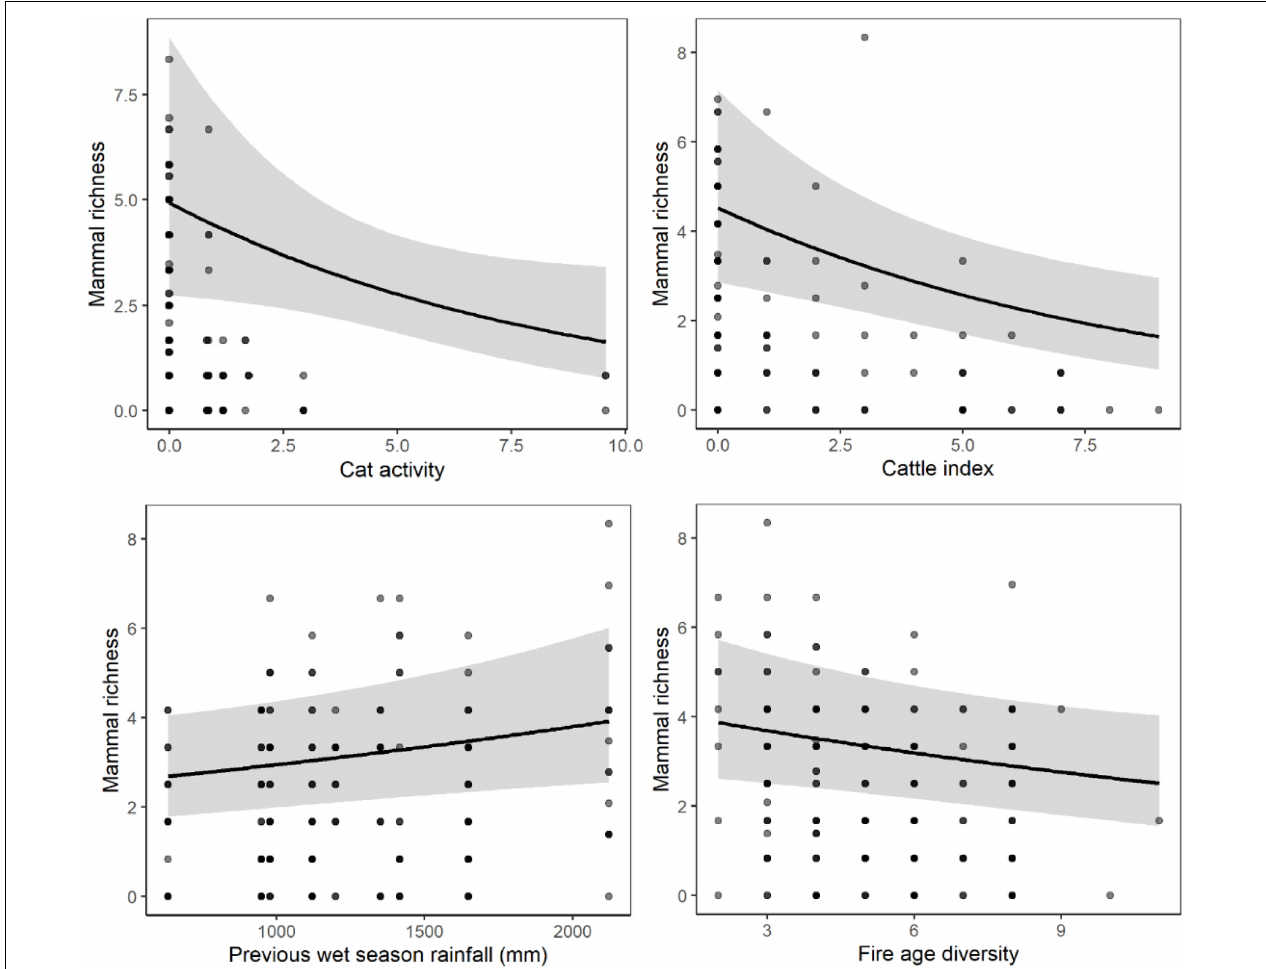
FIGURE 5 | Mammal richness [species per 100 trap nights (tn)] in sandstone habitat shown only for highly influential predictor variables sampled at the 1, 5, and 10 km scale around each site (see Table 2 ). Relationships for each variable were derived from GLMM predictions while holding other explanatory variables constant at their median level. Model fit is shown by a black line and the gray band represents the 95% confidence interval. Gray circles indicate observed data values and are darker when repeated observations occur at the same